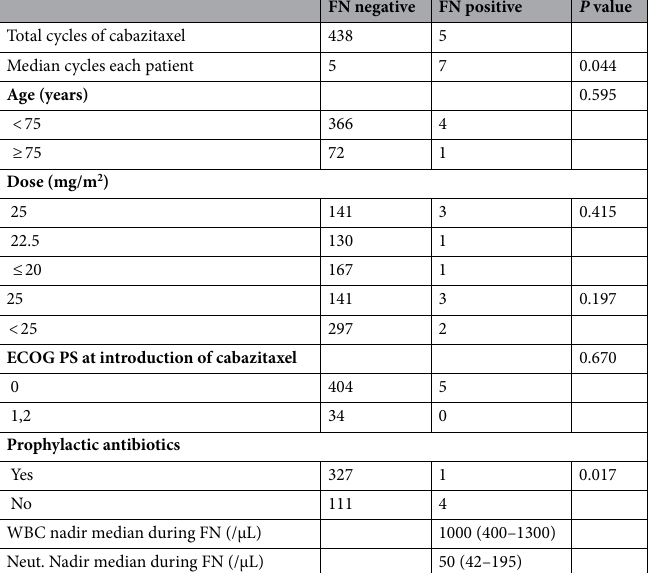
Table3. Comparison of the administration cycles of cabazitaxel according to the development of FN. ECOG PS, Eastern Cooperative Oncology Group performance status; WBC, white blood cell; Neut., neutrophils; FN, febrile neutropenia.